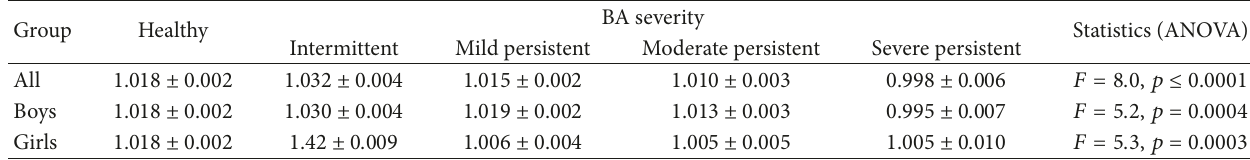
Statistics (ANOVA)